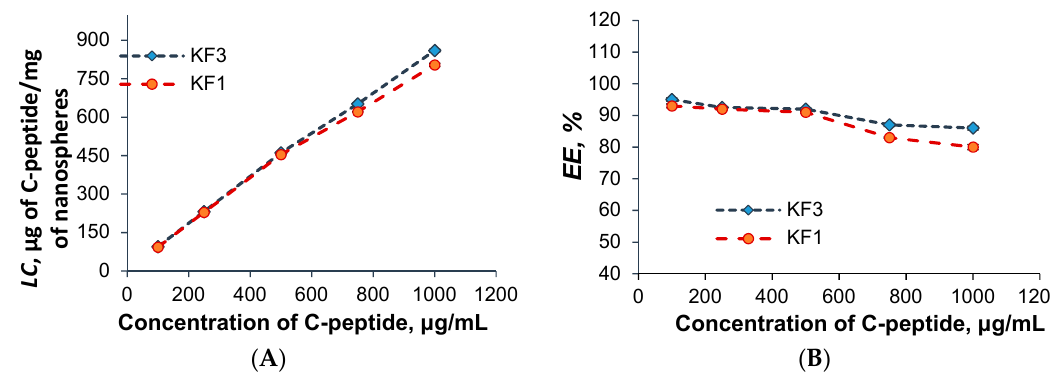
Figure 7. Dependence of loading capacity (LC) ( A ) and encapsulation efficiency (EE) ( B ) on initial concentration of C-peptide.